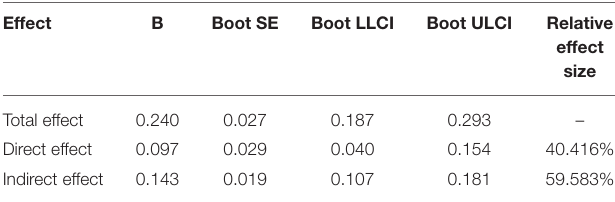
TABLE 3 | Direct and indirect effects of GSE on PR ( N = 881).